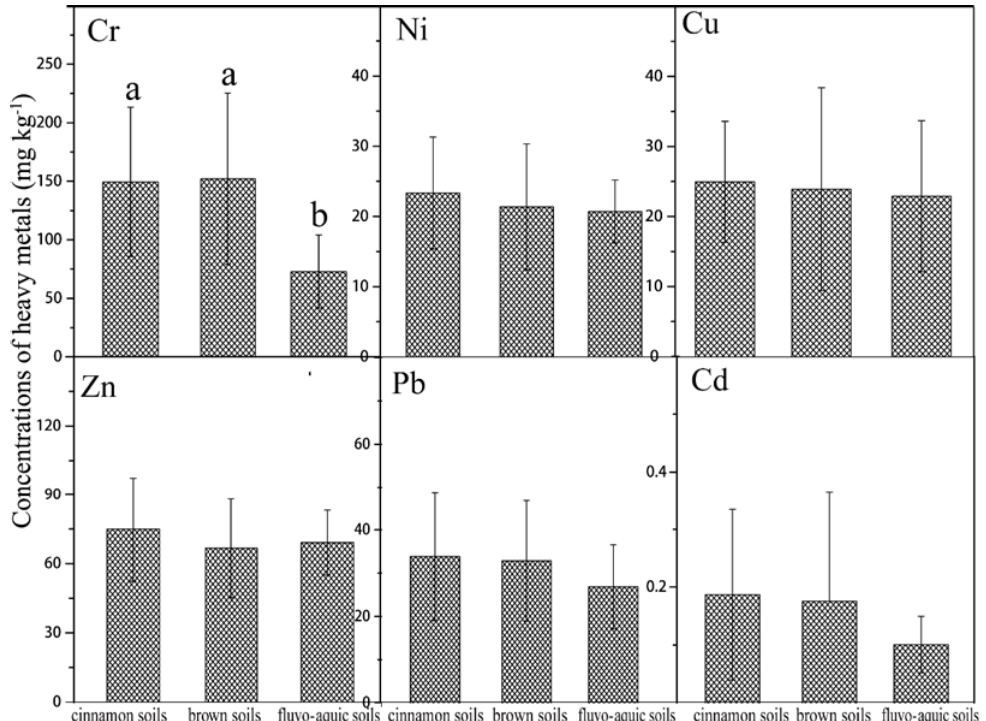
Figure 5. The distribution pattern of heavy metals in the three soil types. Bars sharing the same letter are not significant at α = 0.05 (Duncan test).